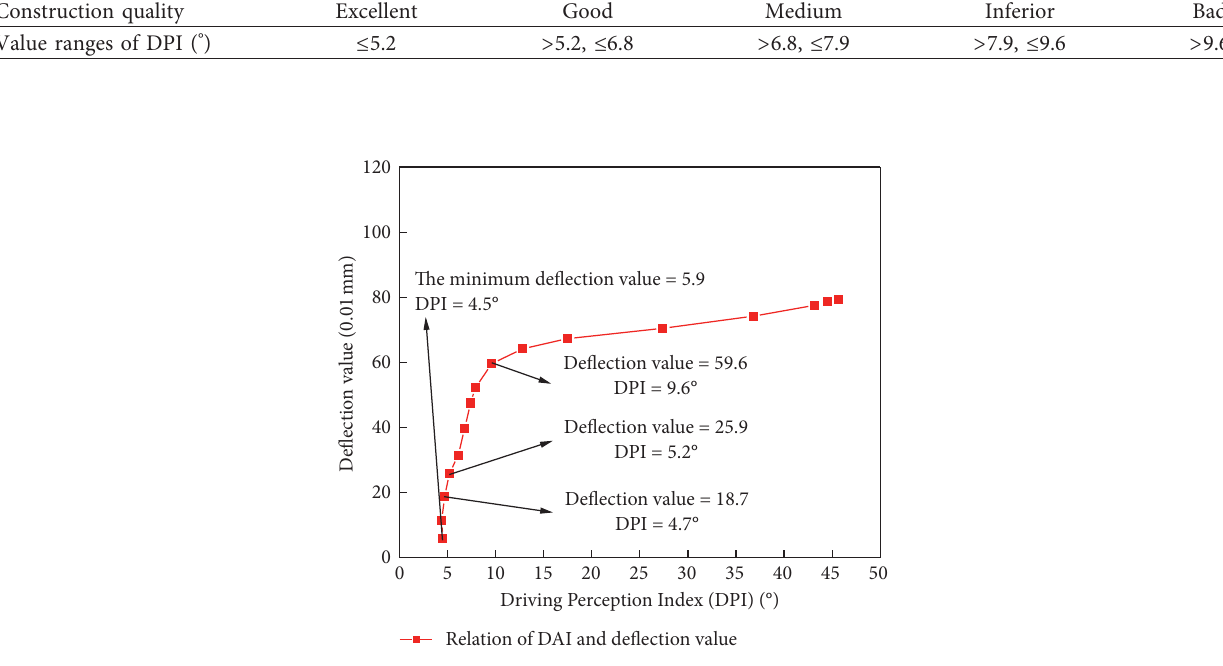
Figure 15: The relationship between deflection value and